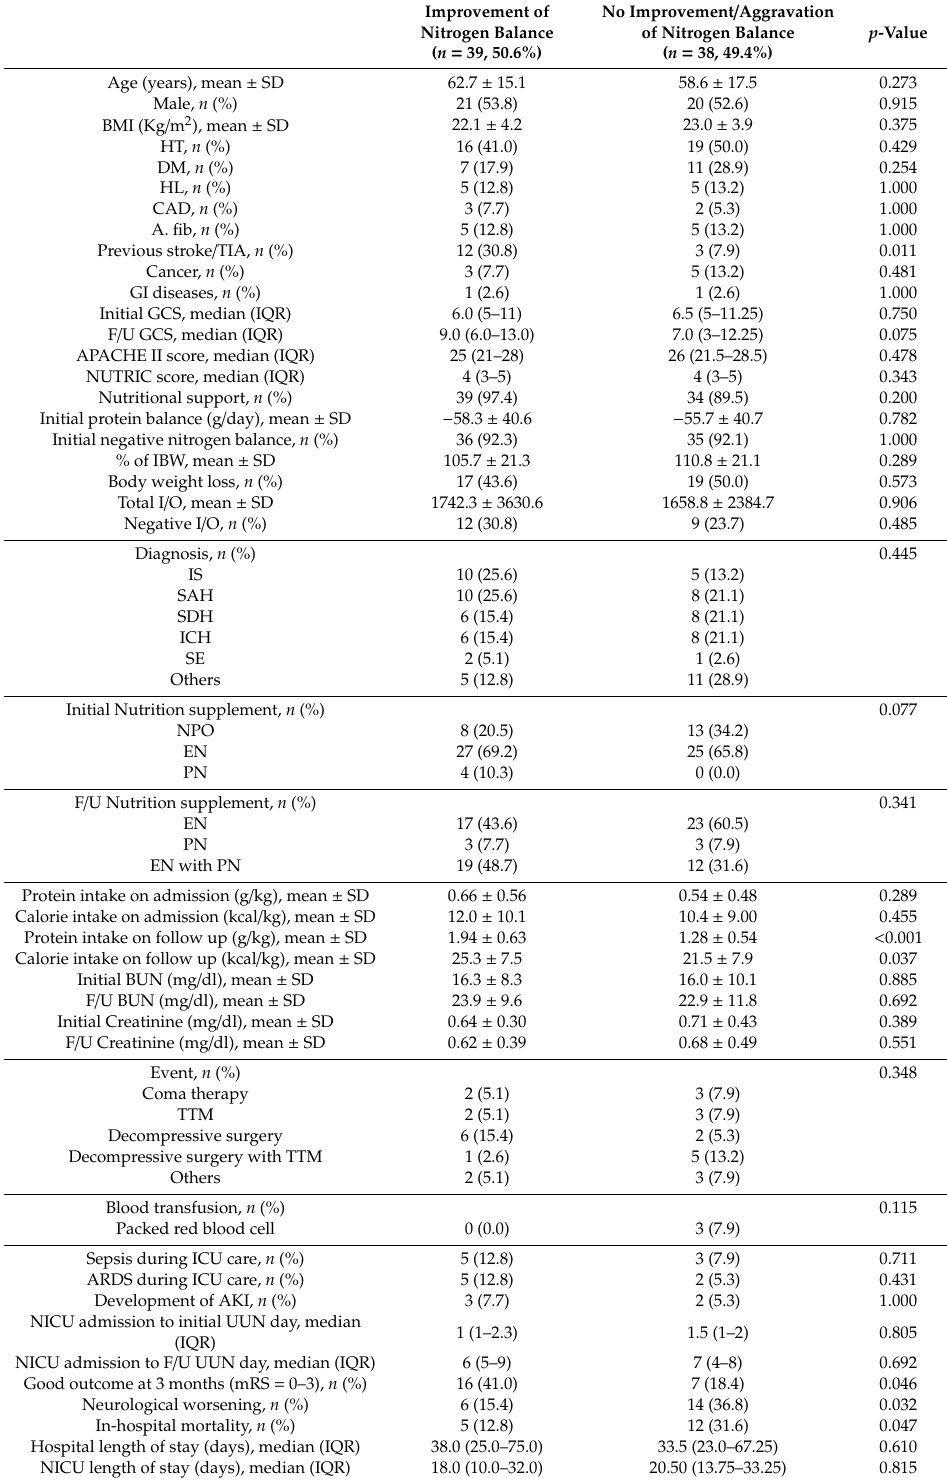
Table 2. Clinical characteristics according to the improvement of nitrogen